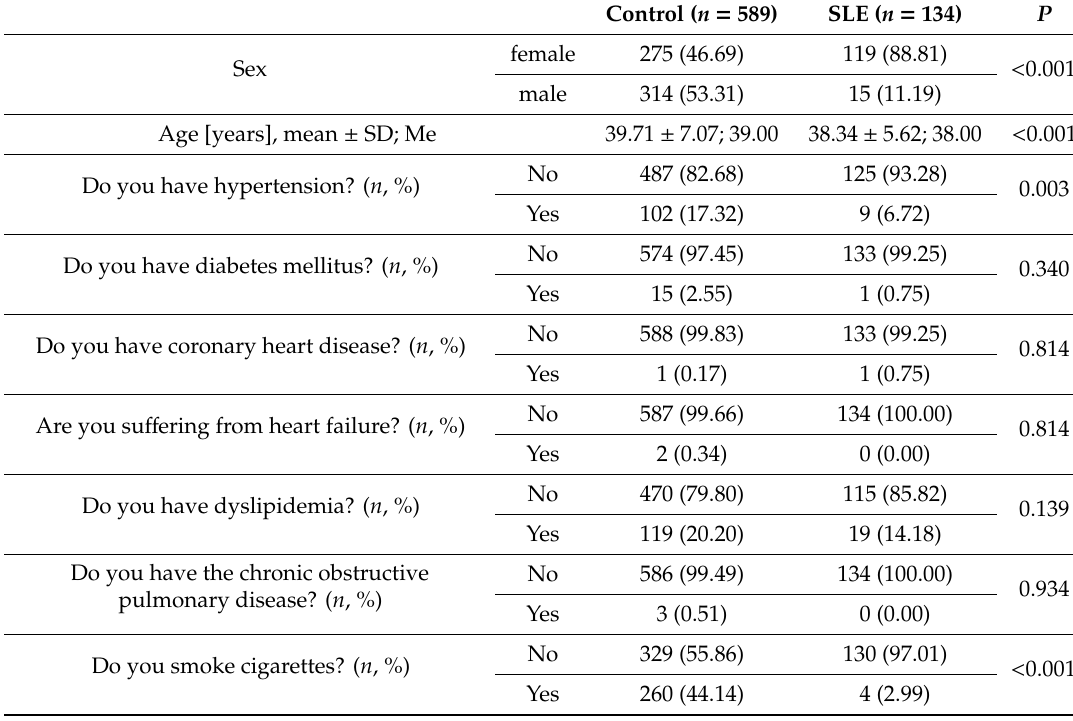
Table 1. Comparison of selected parameters in patients with and without systemic lupus